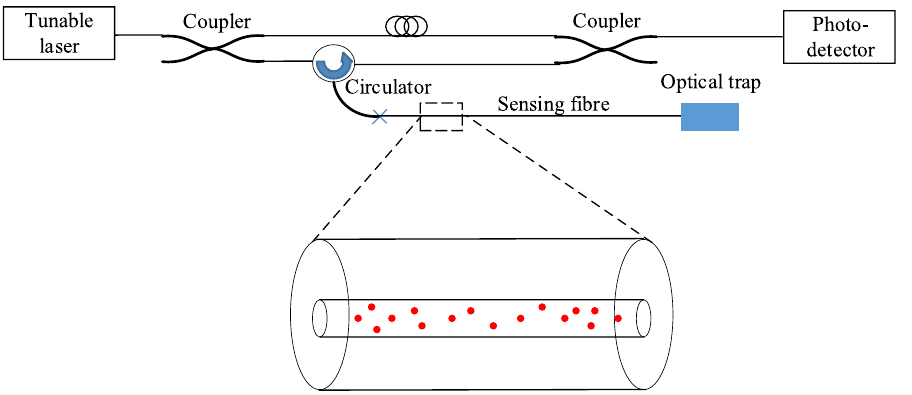
Figure 9. Experimental setup. The dash rectangular zone shows a gauge length which has been enlarged. Red dots indicate randomly positioned gold NPs in the core of the optical fibre. The core of the optical fibre is surrounded by outer